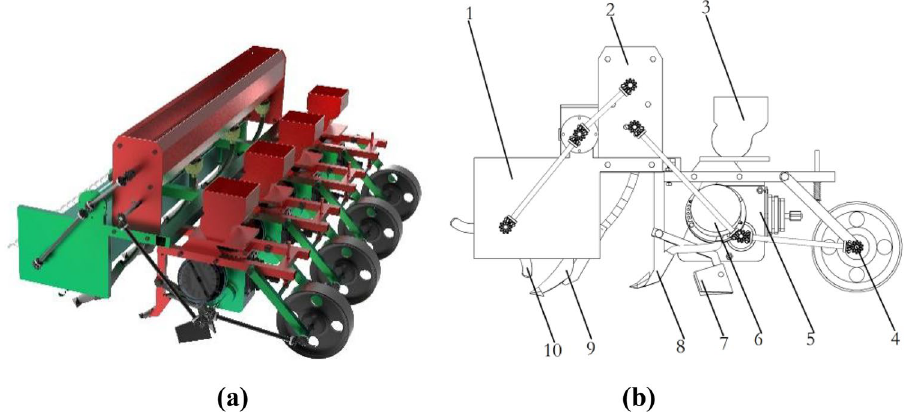
Figure 1. The overall structure of the corn planter with the inclined seed-metering device. ( a ) 3D graphic of corn planter; ( b ) 2D graphic of corn